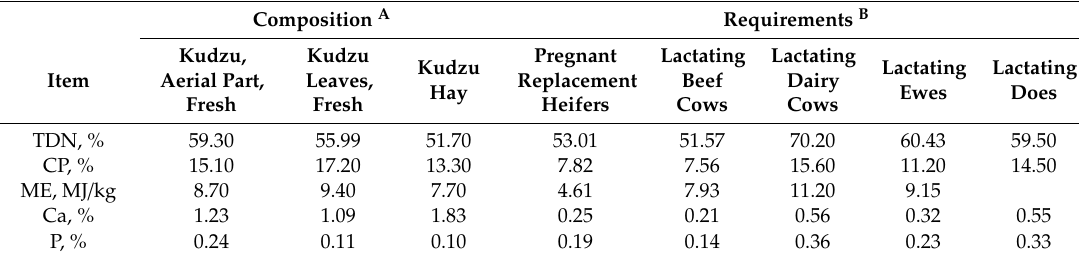
Table 4. Kudzu’s ( P. montana ) (kudzu aerial part (fresh), kudzu hay, and kudzu leaves (fresh)) nutrient composition compared with nutrient requirements of various domestic ruminant species (DM basis)